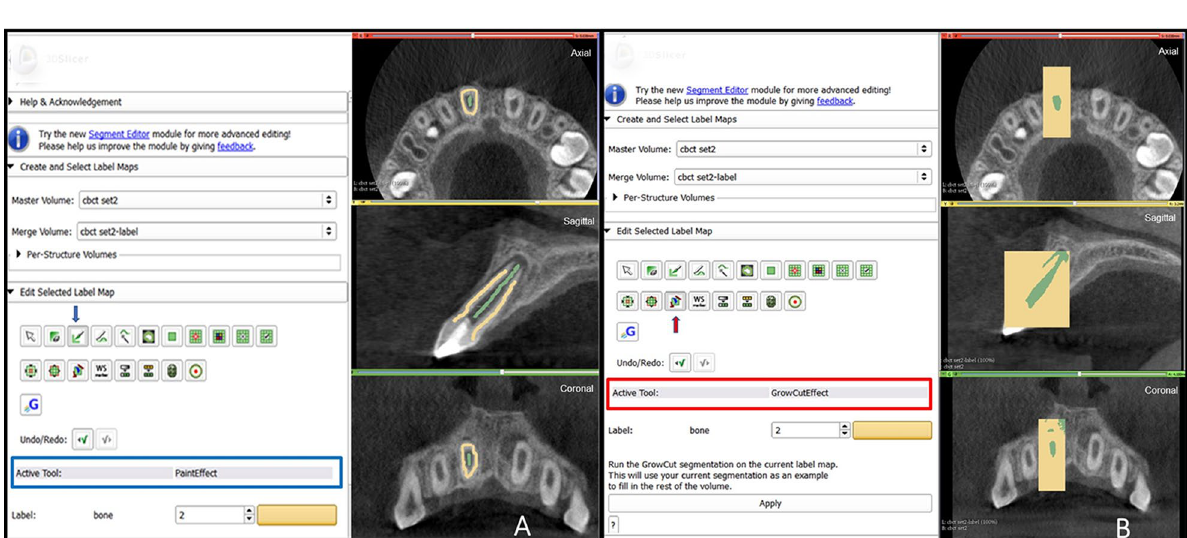
Figure 3. Grow Cut technique in 3D Slicer ( A) initialization of an area inside and outside the ROI using paint effect (blue arrow). (B) automatic competing region- growing using GrowCut effect (red